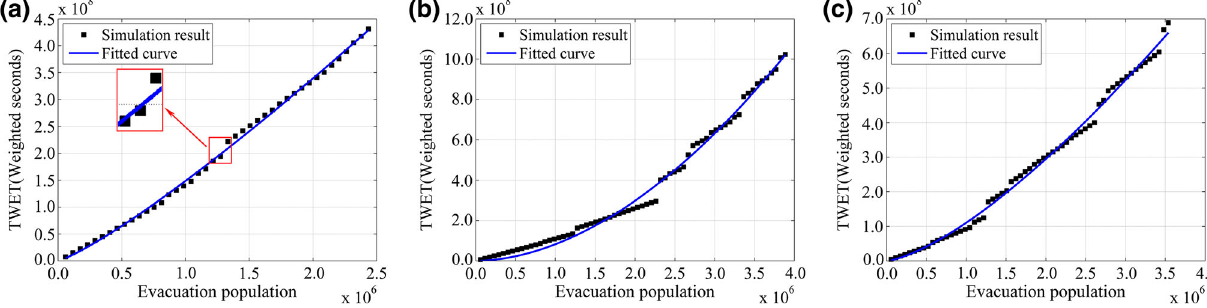
Fig. 6 Relationships between evacuation population and minimum total weighted evacuation time (MIT). a – c Location 1, Location 2, and Location 3,